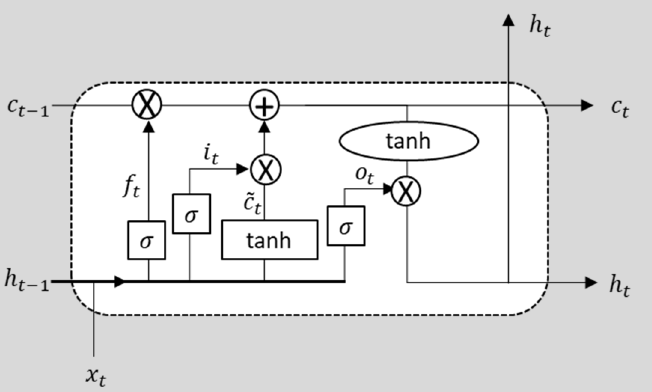
Figure 3. A memory unit in the LSTM architecture ( 𝑐 𝑡 is the cell state at the time step 𝑡 , and ℎ 𝑡 is the hidden state used in the proposed method). hidden state used in the proposed